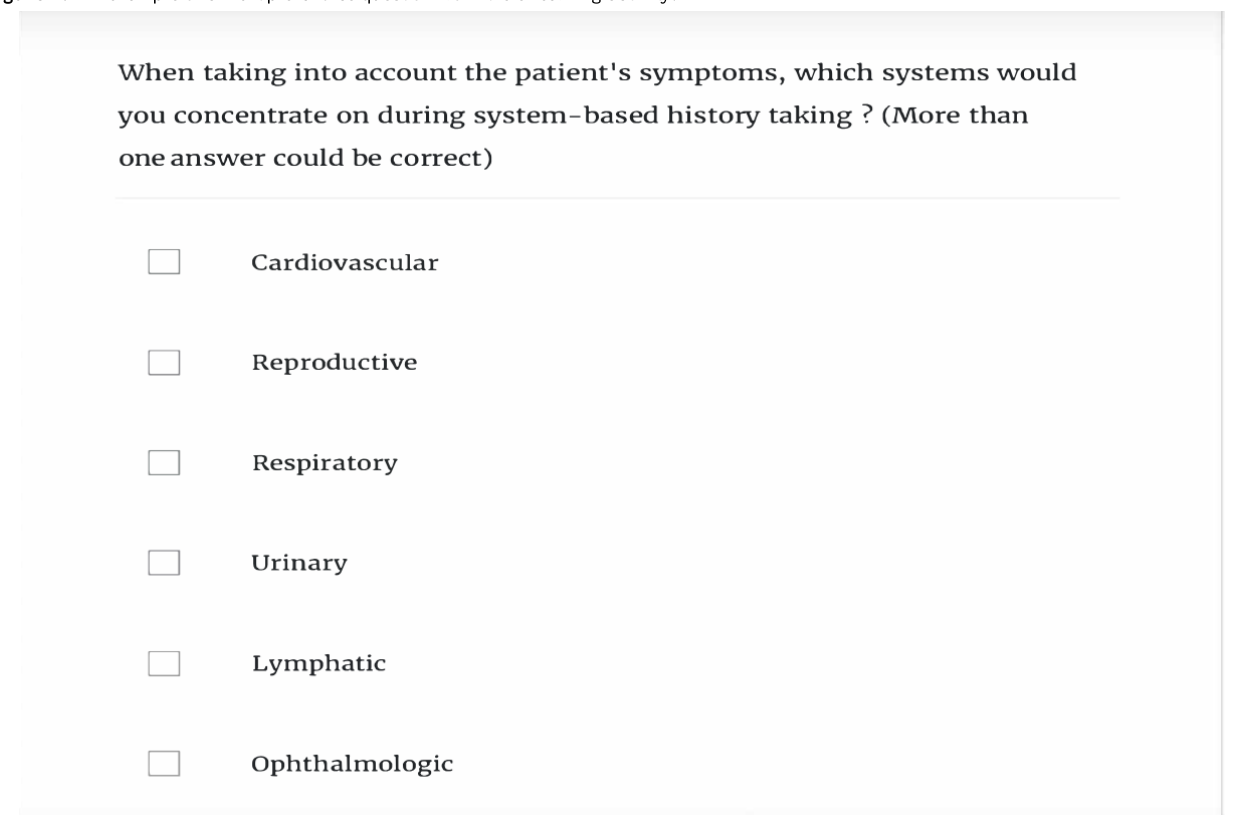
Figure 1. An example of a multiple-choice question from the e-learning